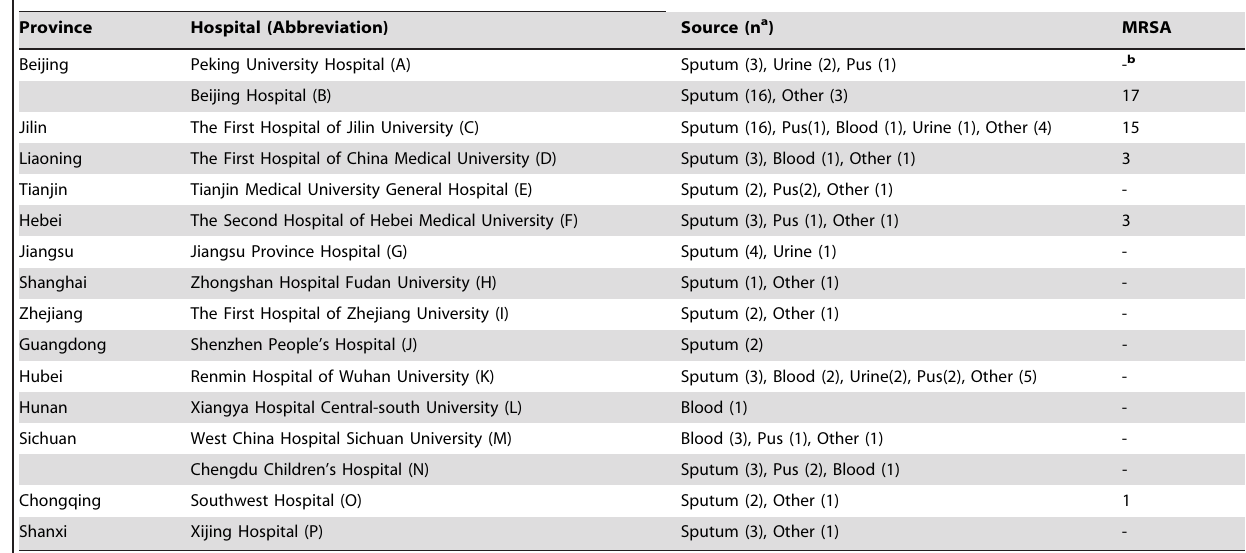
Table 3. Information for S. aureus clinical